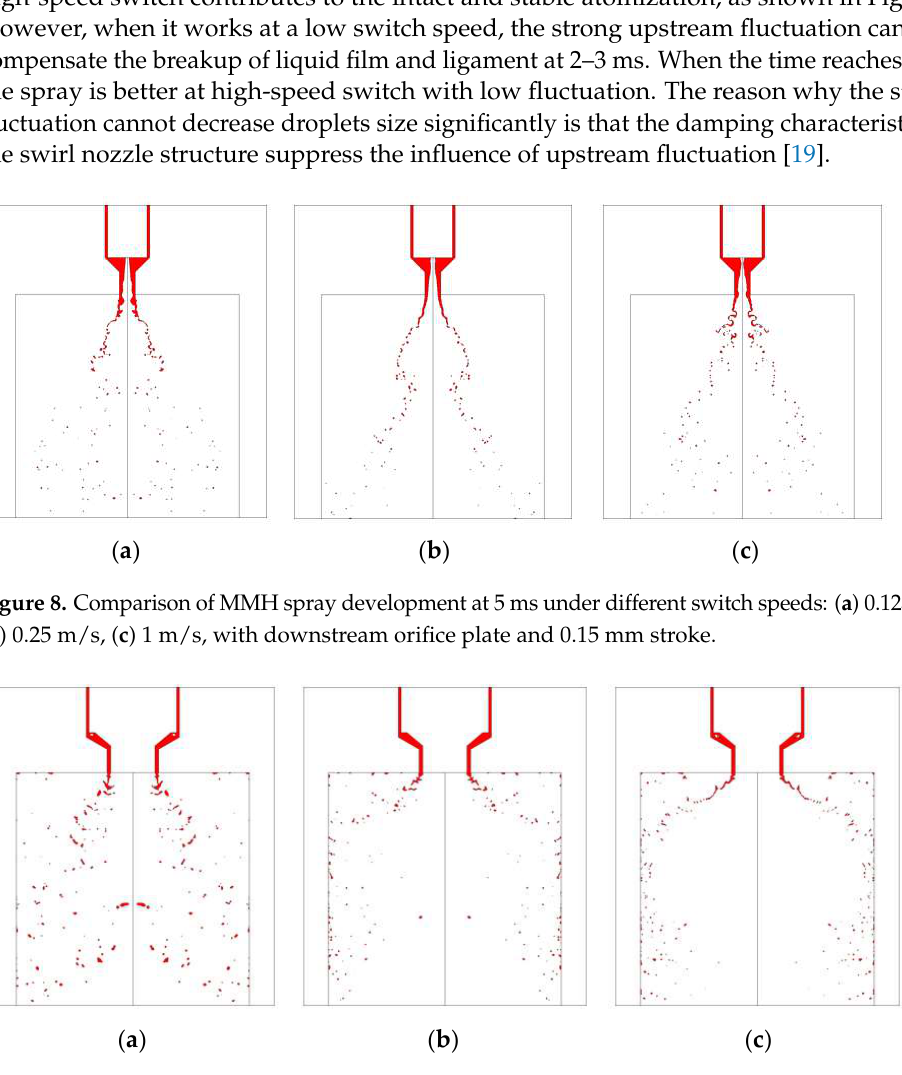
m/s, ( b ) 0.25 m/s, ( c ) 1 m/s, with downstream orifice plate and 0.15 mm stroke. ( b ) 0.25 m/s, ( c ) 1 m/s, with downstream orifice plate and 0.15 mm